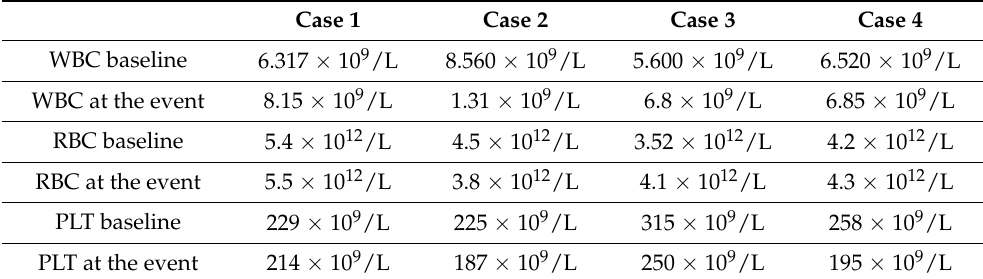
Table 3. Blood values of patients who suffered from cerebrovascular events. Case 1 Case 2 Case 3 Case